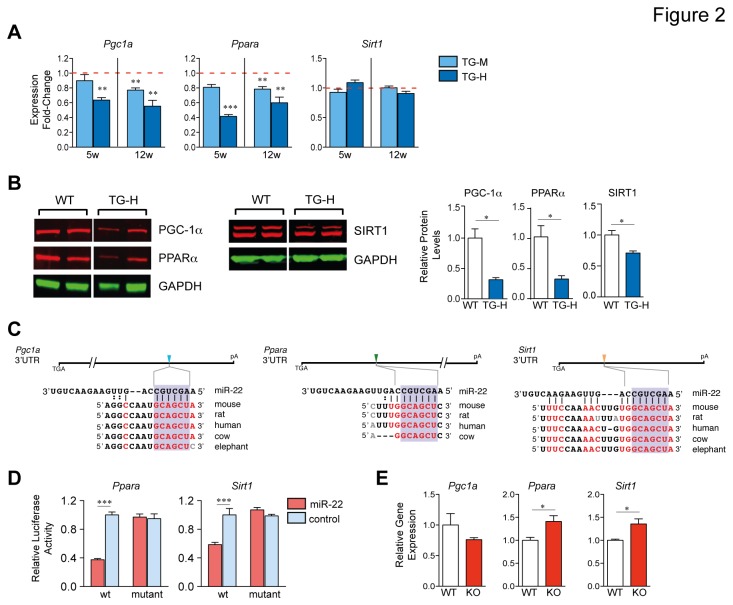
miR-22 co-represses PGC-1α, PPARα, and SIRT1 in the heart.(A) Pgc1a, Ppara and Sirt1 mRNA was quantified by real-time PCR from ventricles of 5- (5w) or 12-week (12w) old mice of indicated genotypes. Bars represent expression normalized with WT set equal to 1.0 (n = 3-4). (B) Representative Western blot and quantitation of PGC-1α, PPARα, and SIRT1 levels from ventricular lysates obtained from 12-week old TG-H and WT mice. GAPDH was used as a loading control (n = 3 immunoblots from three mice each genotype). (C) Pgc1a, Ppara and Sirt1 each contain highly conserved miR-22-mRNA interaction motifs within their 3’ UTRs. (D) Luciferase activity in 3T3 MEF cells transfected with indicated wt or site mutant (mut) 3’ UTR reporter constructs in the presence of miR-22 or control miR mimic. Data are from two experiments carried out in triplicate. (E) Cardiac Pgc1a, Ppara and Sirt1 mRNA expression levels were evaluated by qPCR from 6-week old miR-22-deficient (KO) and WT mice (n = 3). Student t test, (A,B,E); or 2-way ANOVA with the Tukey post hoc test, (D). *, P<0.05; **, P<0.01;.***, P<0.001.